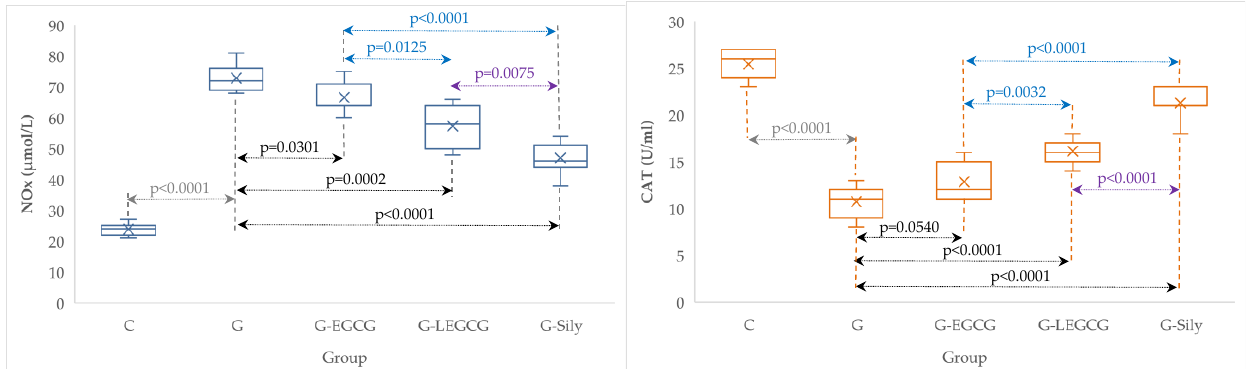
Figure 2. Serum levels of NOx and CAT by groups. C, control group; G, gentamicin group; G-EGCG, gentamicin and epigallocatechin gallate group; G-LEGCG, gentamicin and liposomal epigallocatechin gallate group; G-Sily, gentamicin and silymarin group.